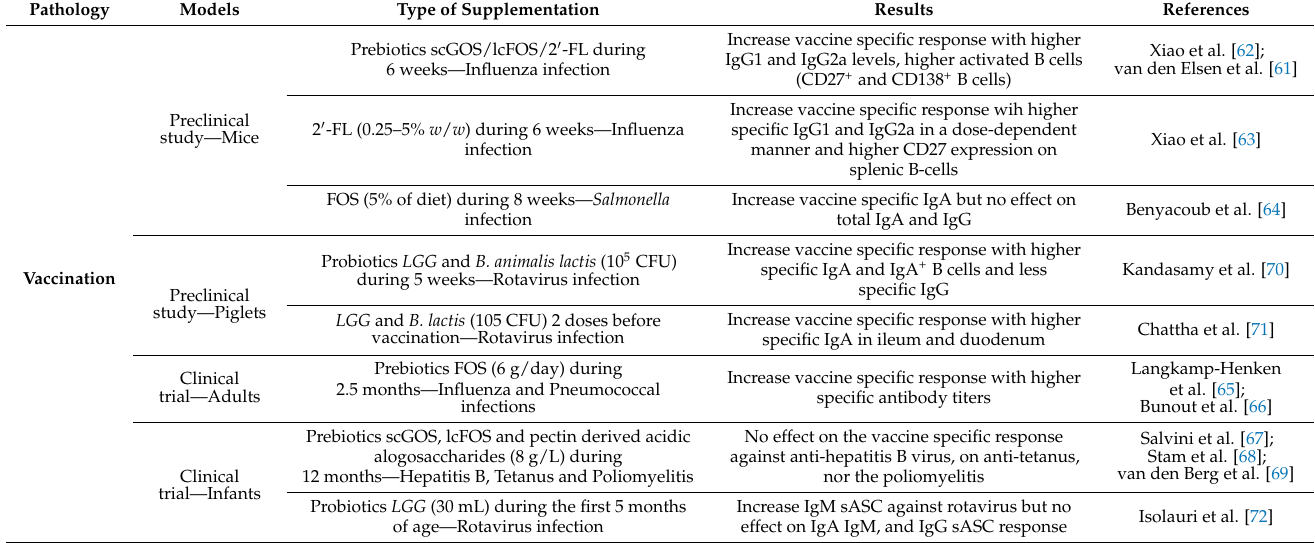
Table 3. Effects of prebiotics, probiotics and synbiotics on the humoral B response in different contexts of